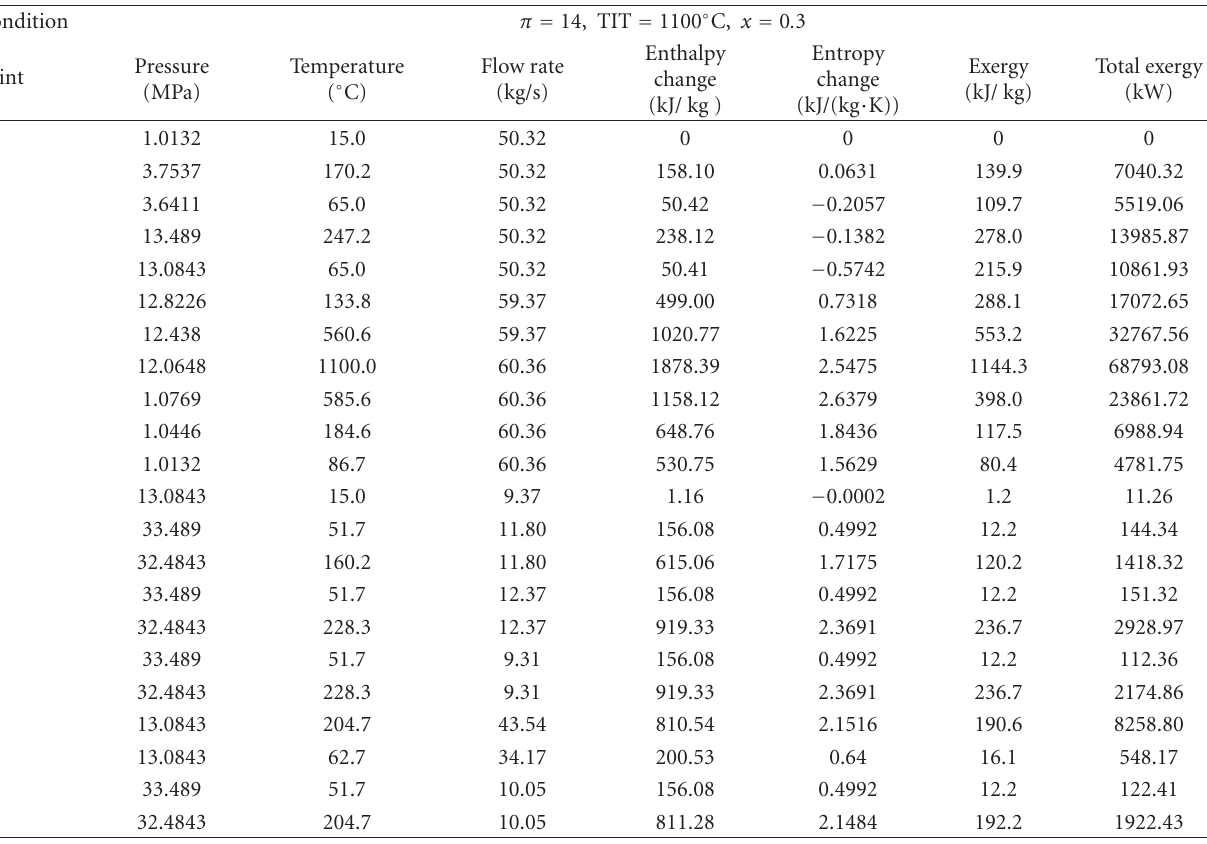
Table 2: The data of every state point parameters for hat cycle with solar energy. Condition